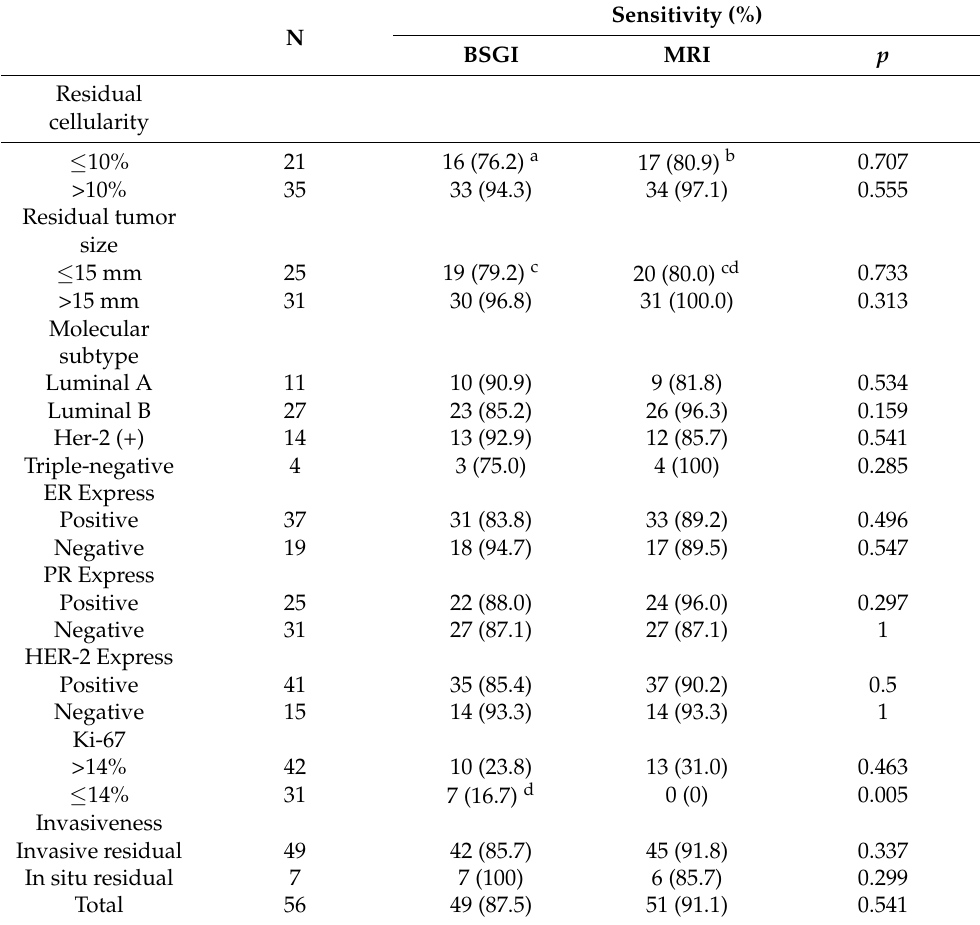
Table 4. Statistics regarding the consistency between BSGI, breast MRI, and pathological measure- ments of residual tumor following NAC